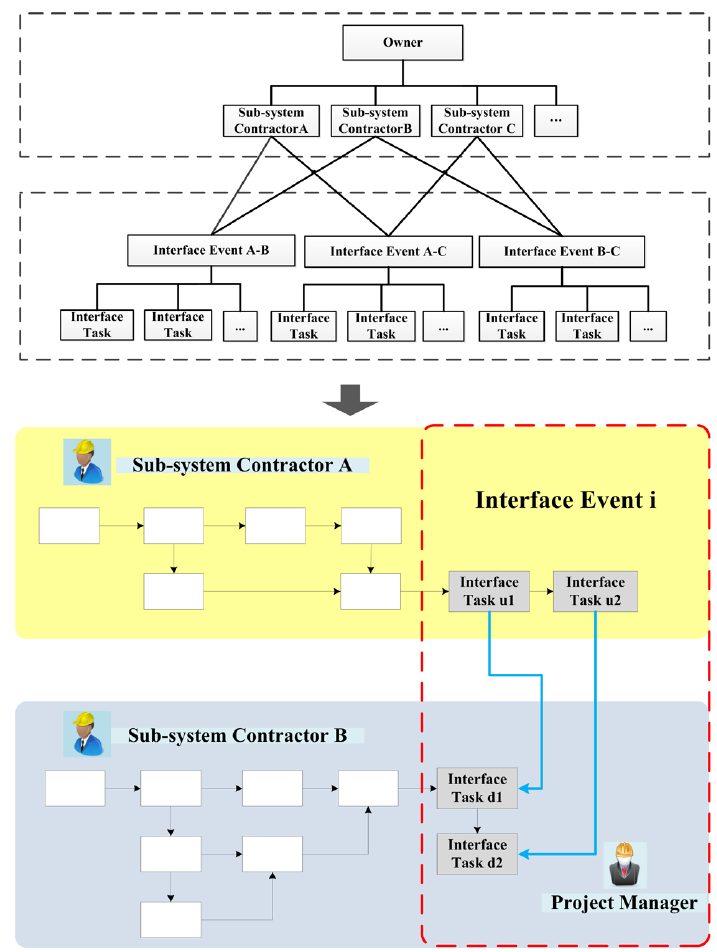
Fig. 1. Interface events and interface